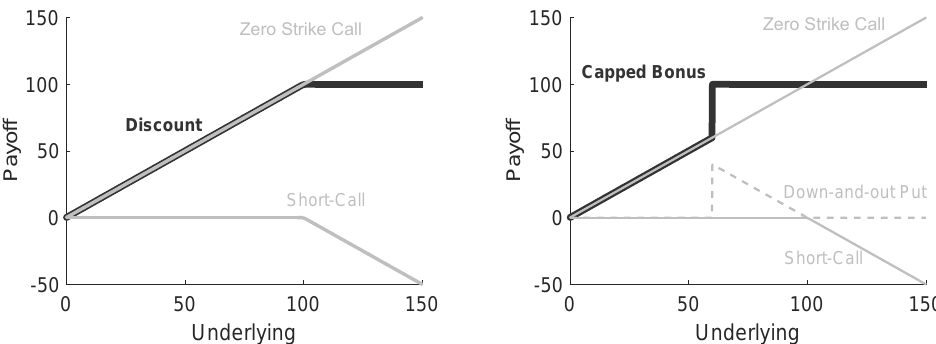
Figure 3. Discount and Capped Bonus Certificates’ Payoff and Replication. Illustration of the payoff function and replication scheme for discount ( right ) and capped bonus certificates ( left ). Here, the cap level is set to 100 and the barrier to 60 as an